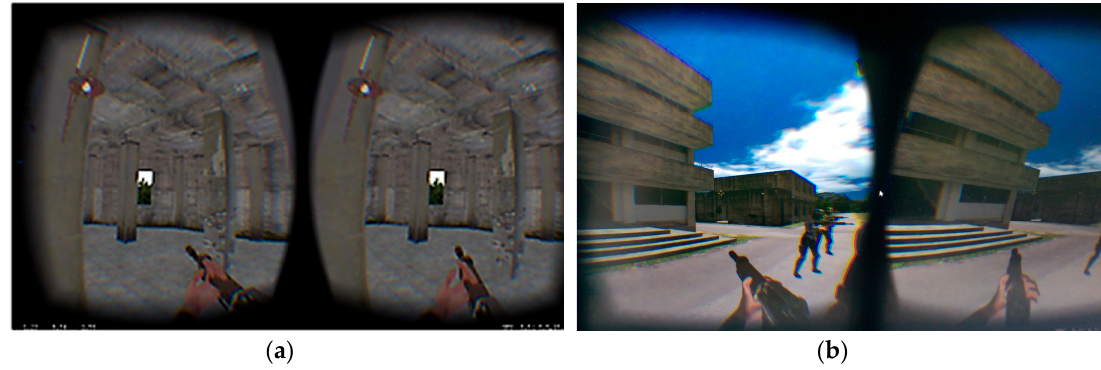
Figure 15. Virtual environment on a HMD. ( a ) An indoor view. ( b ) An outdoor view.